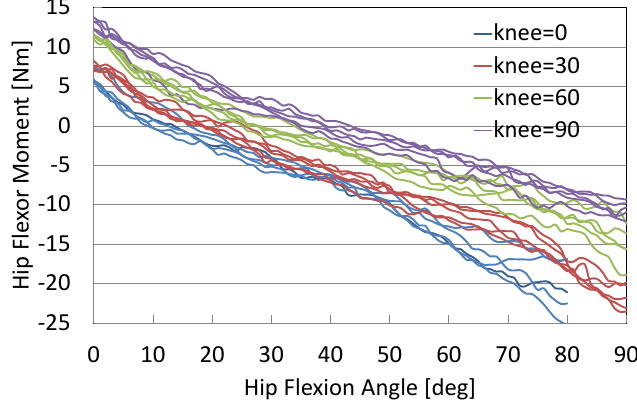
Figure 5 Passive resisting moments of five repetitive measurements for a representative older subject with various knee angles of flexion are plotted against the hip flexion angles.